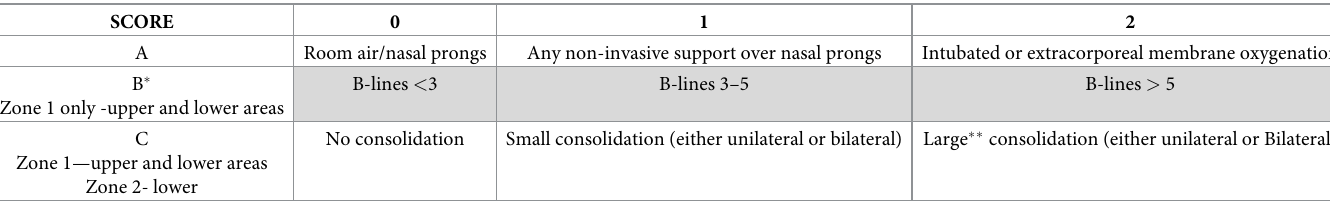
Table 1. The Point of Care Lung Ultrasound Injury Score (PLIS) grading